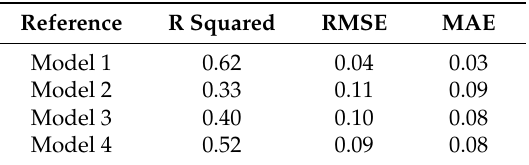
Table A1. Repeated k-fold cross validation of the models (k = 5; repetitions = 100) mean performance metrics for the different UAS models. R-squared: coefficient of determination; RMSE: Root Mean Squared Error; MAE: Mean Absolute